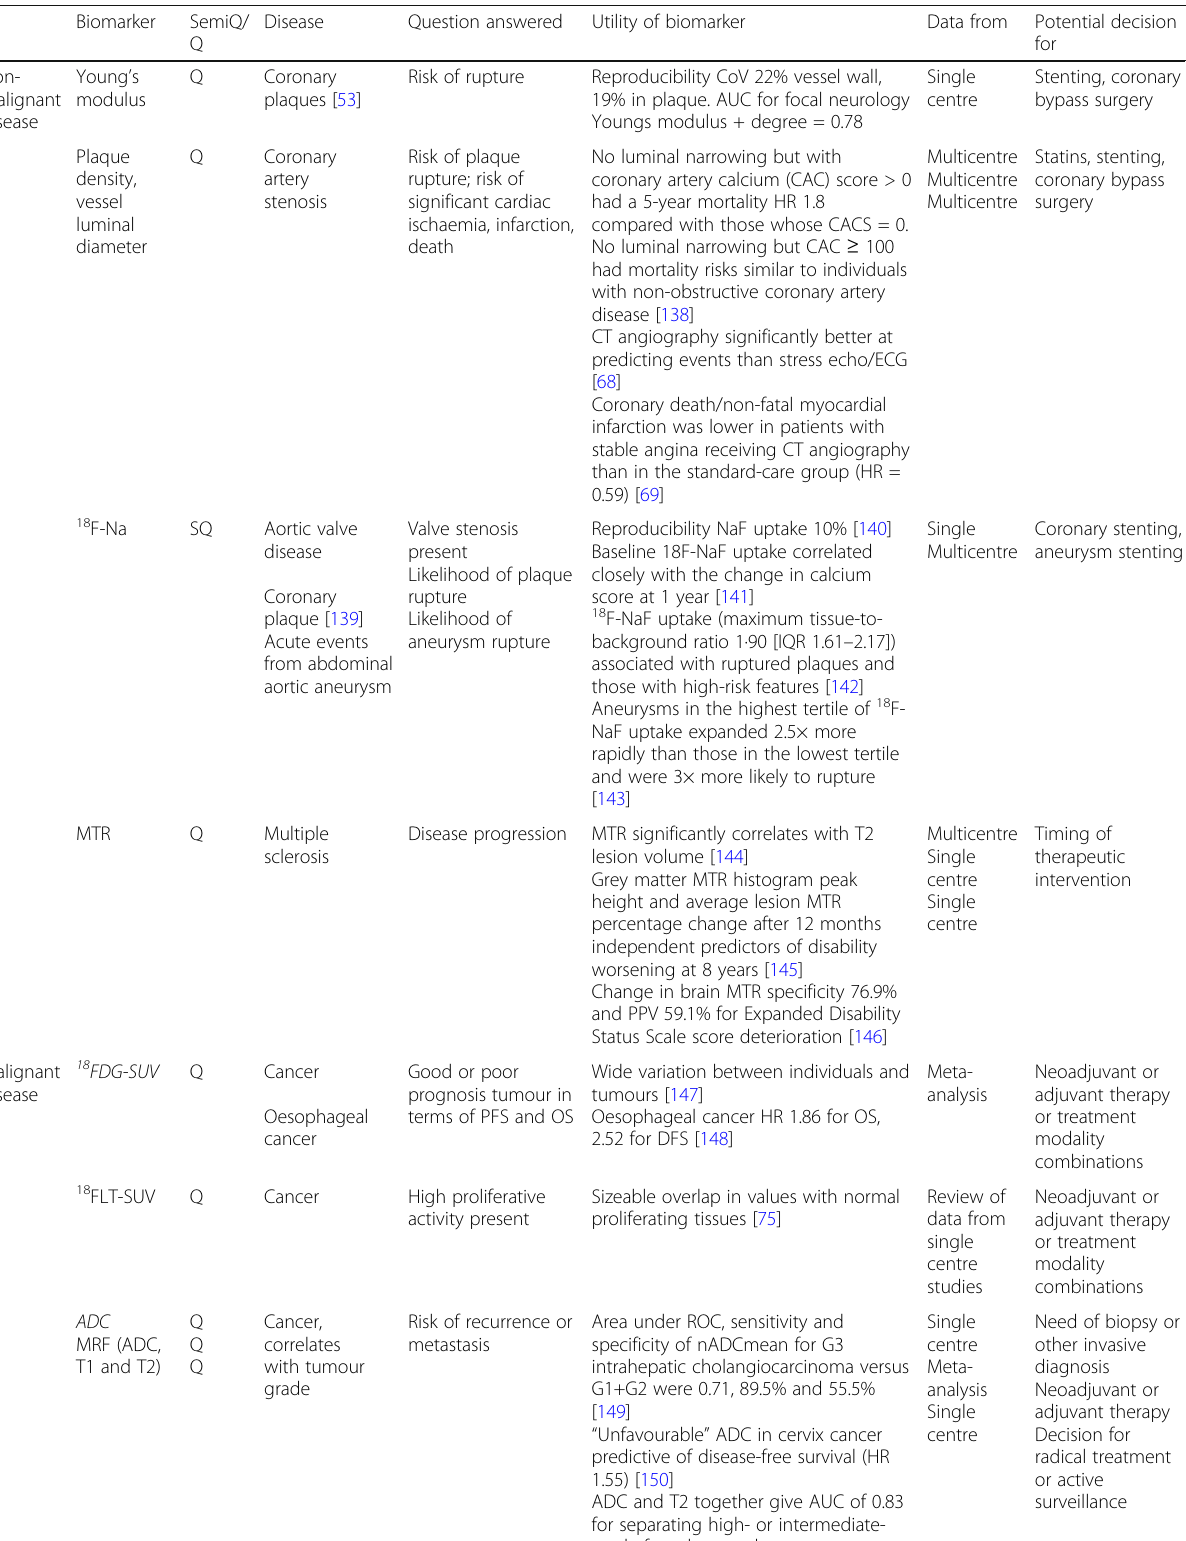
Table 2 Imaging biomarkers for disease characterisation (semi-quantitative and quantitative) with examples of current evidence for their use that would support